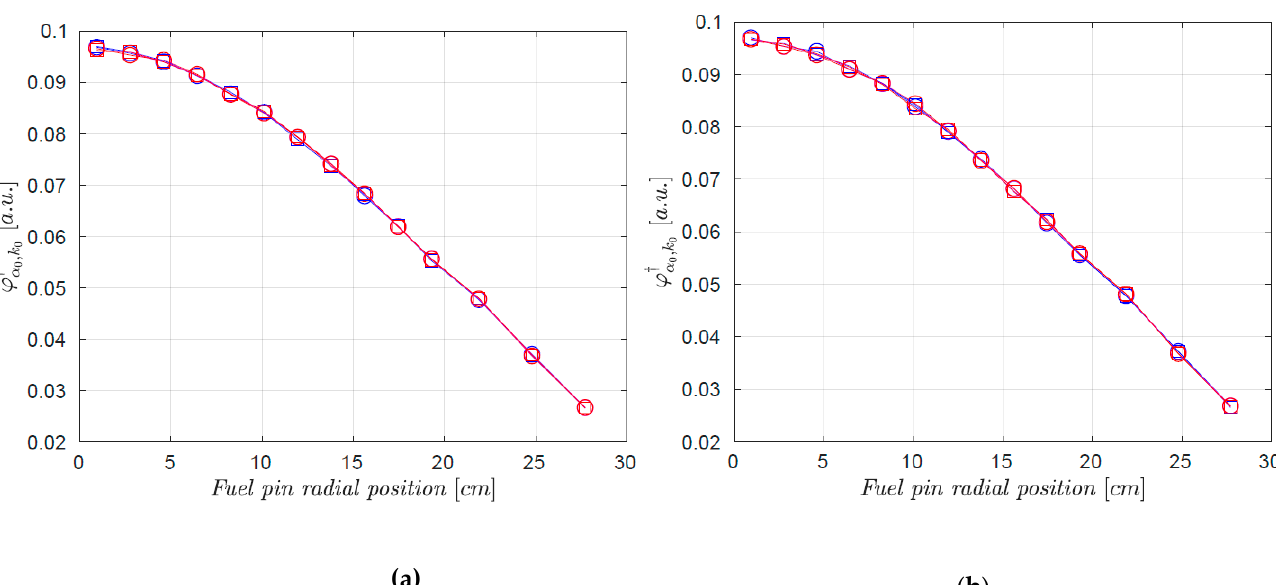
Figure 12. Adjoint fundamental eigenmodes of the CROCUS reactor as a function of the fuel pin positions, H1 ( a ) and H2 ( b ) configurations according to the α - (blue) and k - (red) eigenvalue formulations, with (squares) and without (circles) precursor contributions.